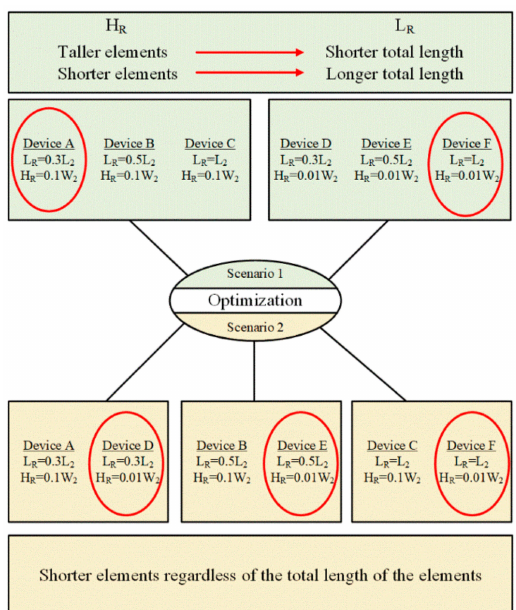
Figure 6. Optimization scenarios and conclusions from the optimum cases in each scenario.